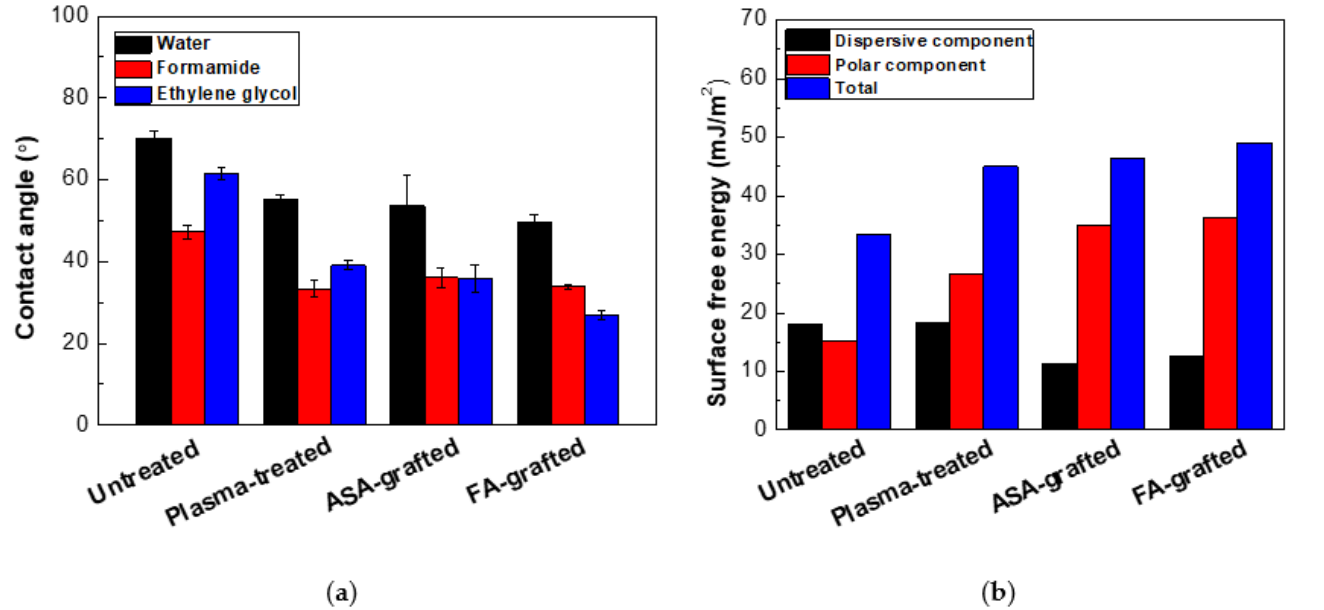
Figure 1. ( a ) The contact angles of the testing liquids on the PLA samples, ( b ) The surface free energy of the PLA samples. Table 1. The contact angles, surface free energy and graft yields of the PLA samples.